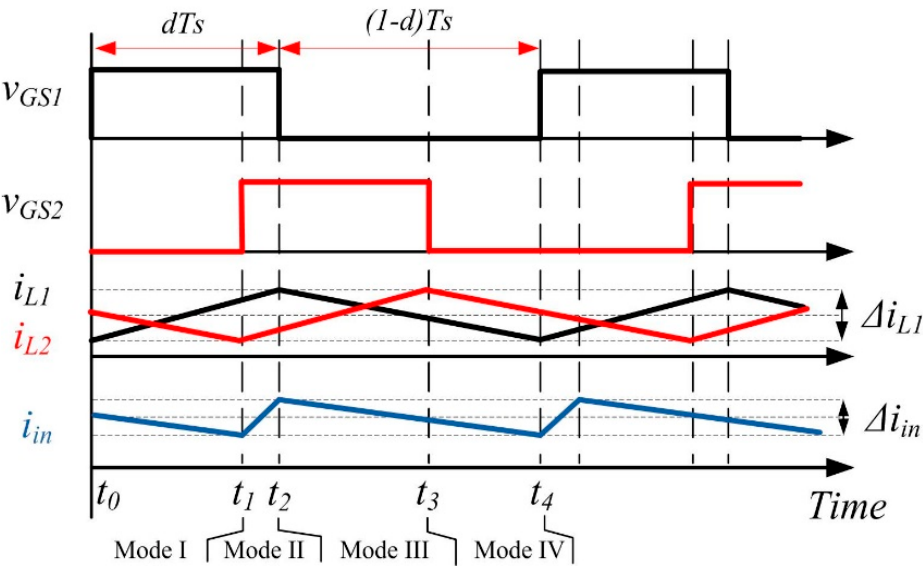
Figure 3. Waveforms of two − phase IBC in operation modes ( d ≤ 0.5).